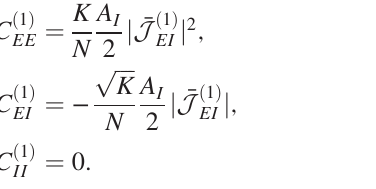
≃ 0 . 1 . For the red dashed line, the other parameters are A I